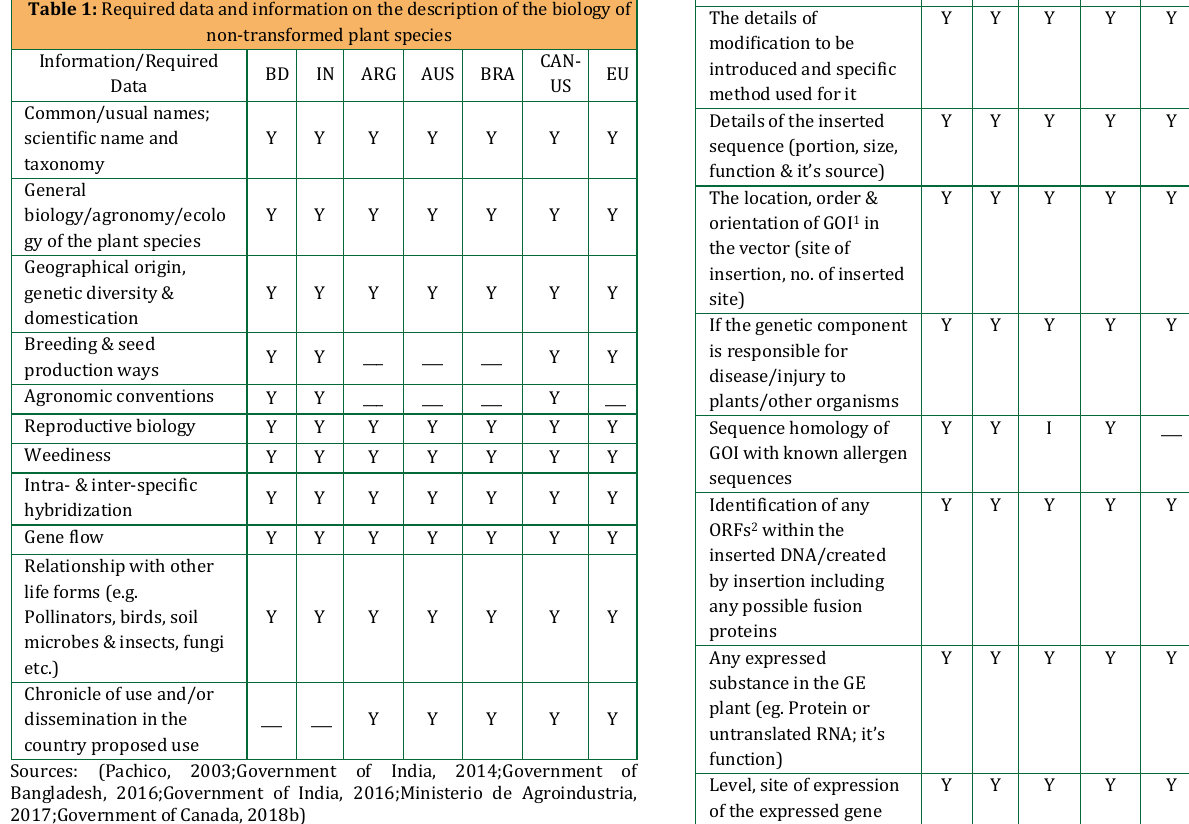
Table 1: Required data and information on the description of the biology of